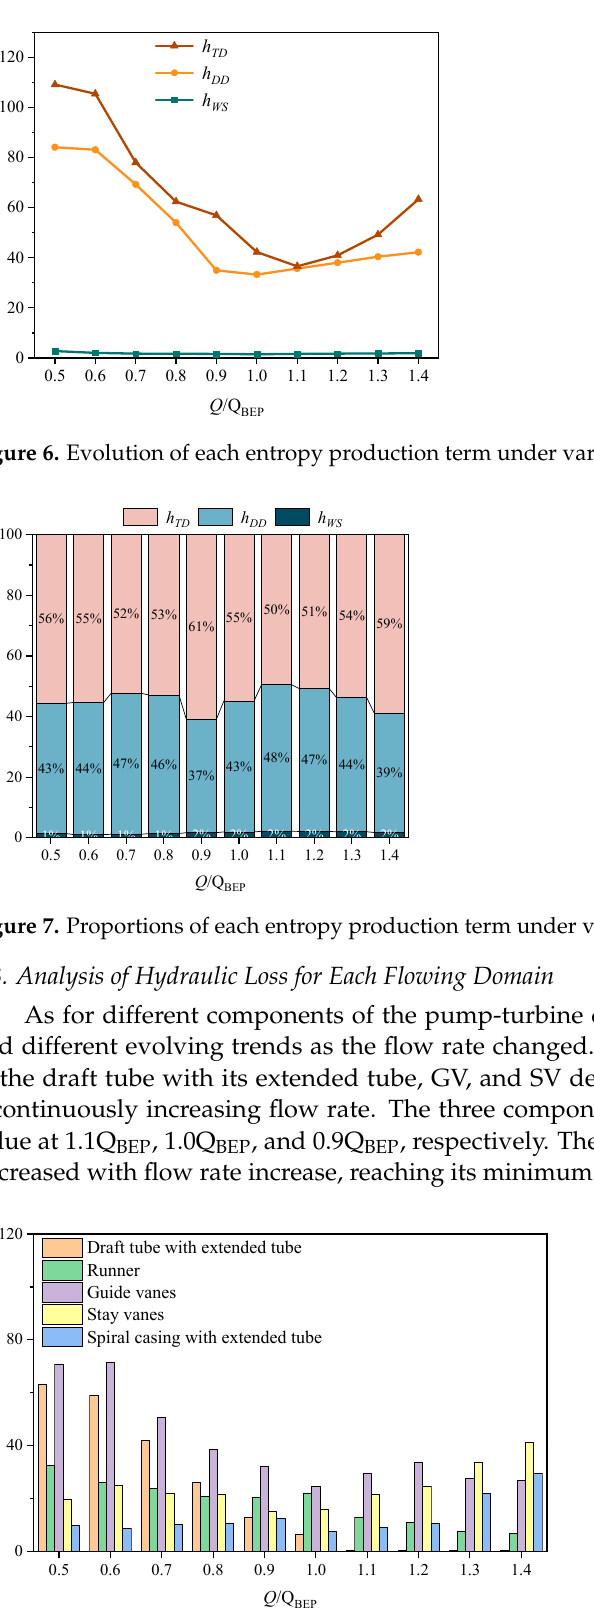
11 of 19 Figure 5. Hydraulic loss comparison between entropy production method and differential pressure method. 3.2. Analysis of Three Hydraulic Loss Compositions The proportion and variation patterns of three entropy production terms correspond- ing to three hydraulic loss compositions are shown in Figures 6 and 7. The entropy pro- duction in the near-wall region mainly originated from the large velocity gradient caused by the shear stress between the first layer of the grid node and the wall, which could be approximated as friction loss. The contribution of the EPWS to the TEP was minimal, con- tributing about 1–2%, and varied slowly with different flow rates. The entropy production of the main flow region was primarily triggered by flow separation, backflow, and vorti-